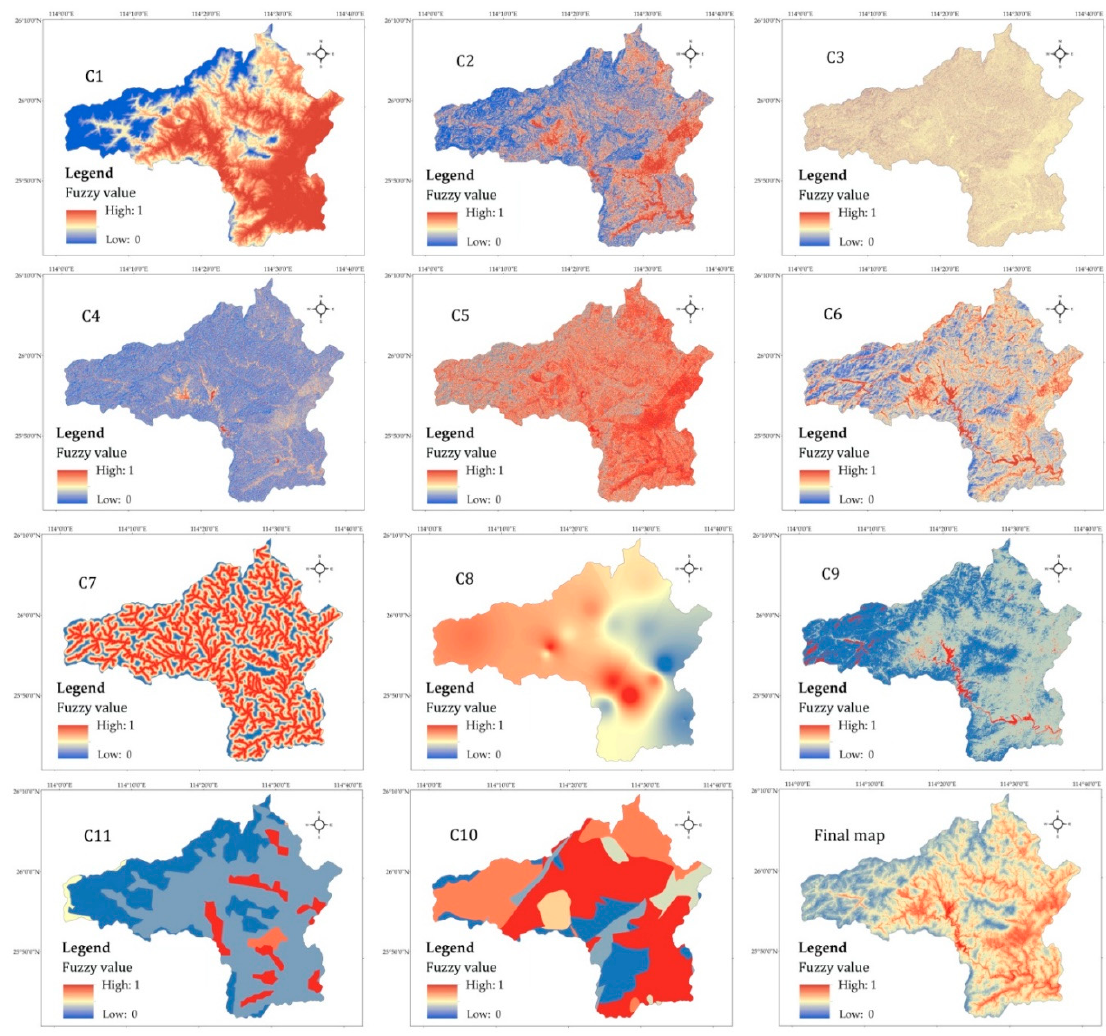
Figure 4. Maps of the standardized criteria for the study area: ( C1 ) altitude, ( C2 ) slope, ( C3 ) plan curvature, ( C4 ) TWI, ( C5 ) STI, ( C6 ) NDVI, ( C7 ) distance from rivers, ( C8 ) rainfall, ( C9 ) land cover/use, ( C10 ) lithology, ( C11 ) soil and final map.